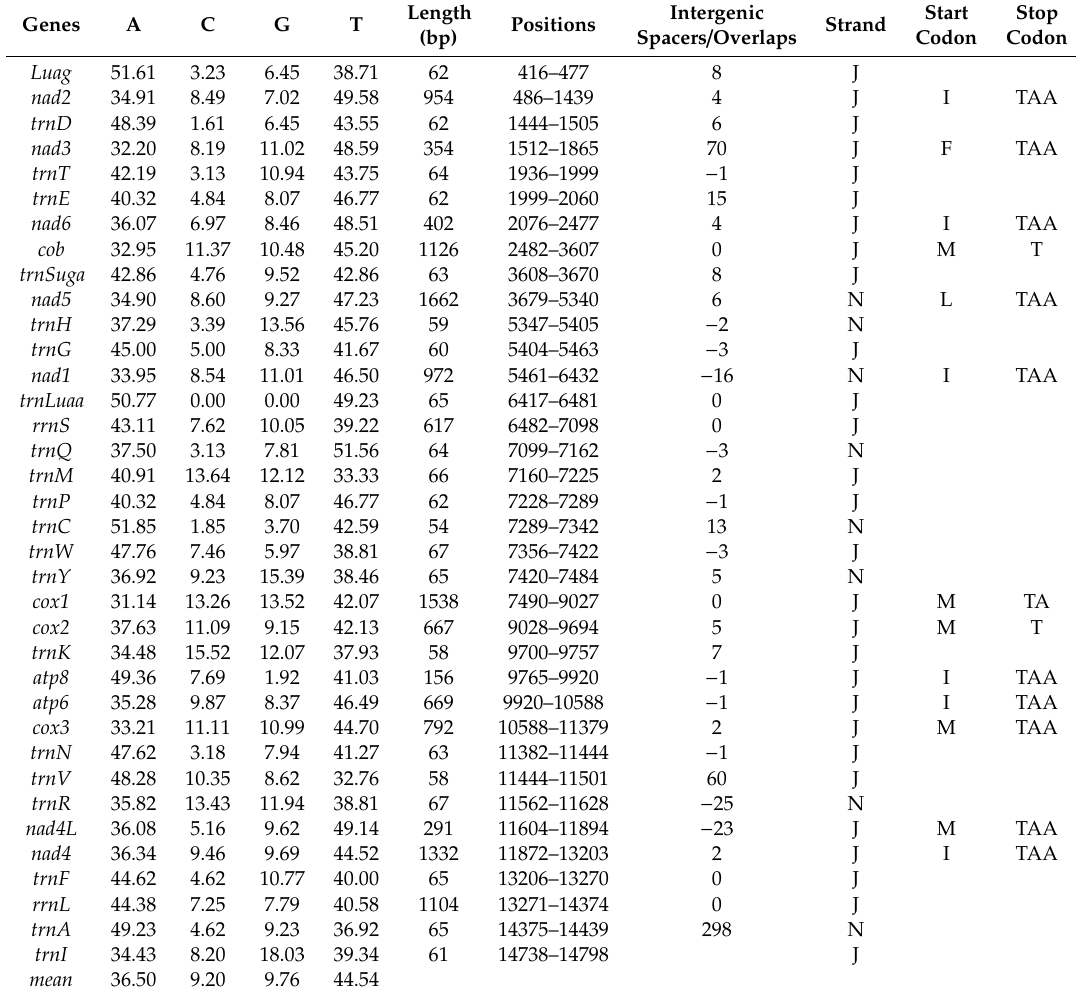
Table 1. Annotation of Acerella muscorum mitochondrial genome (partial). Nucleotide composition is calculated on the coding strand; position refers to GenBank accession NC_026675; spacers (positive numbers) and overlaps (negative) are calculated with respect to the following